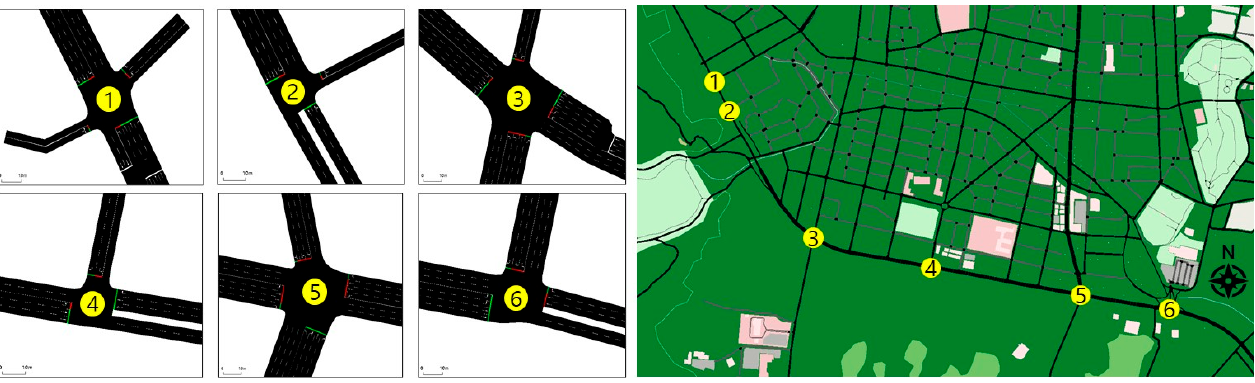
Figure 5. Complex network with six intersections.